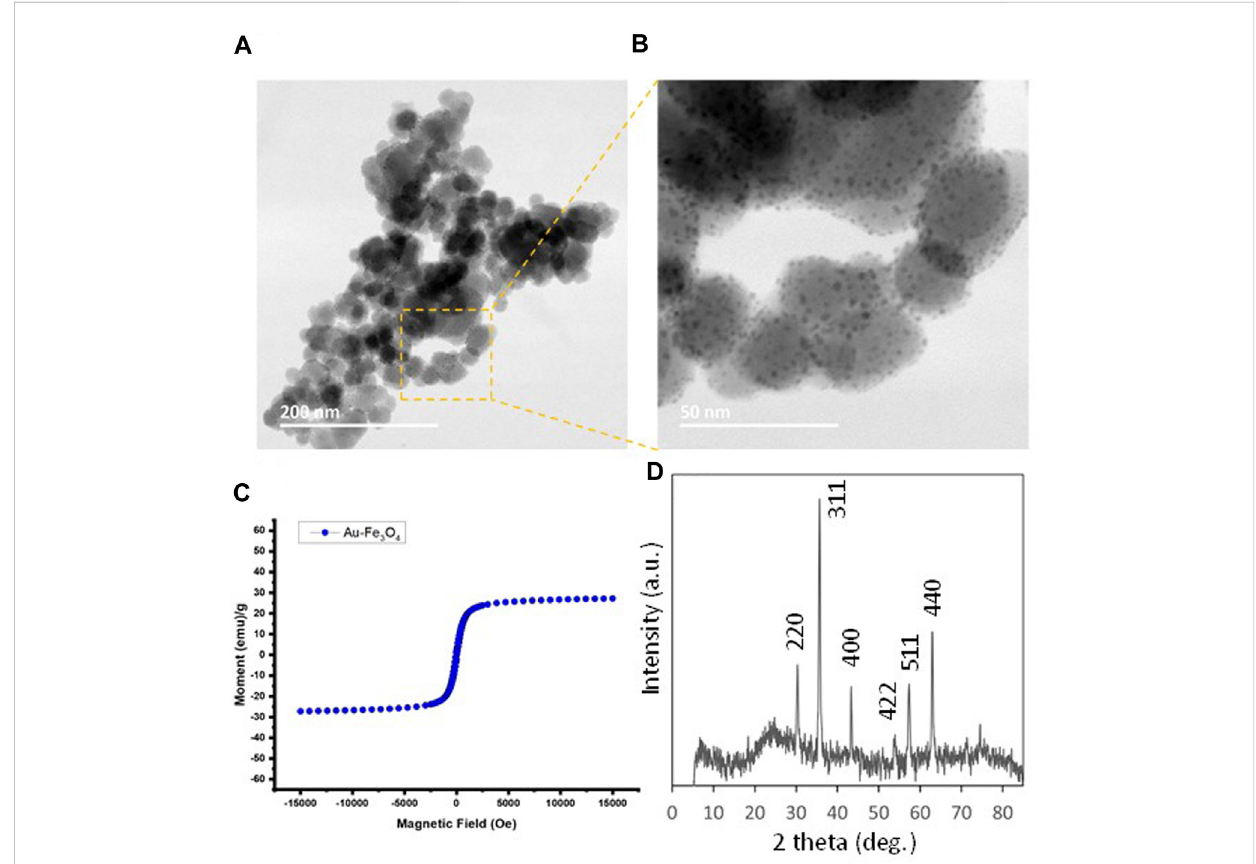
FIGURE 2 (A, B) TEM images for Au-dotted Fe 3 O 4 (10%) nanoparticles prepared by impregnation of gold. (C) Magnetization curve (M vs. H plot) of Au-dotted